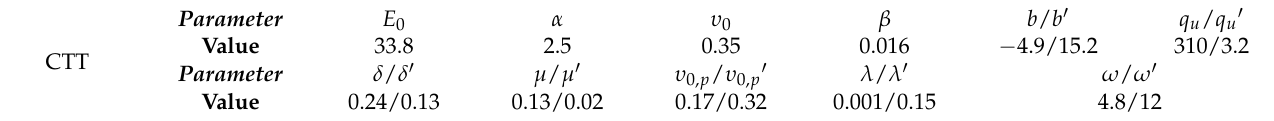
Figure 5. Comparison of prediction with experimental results of silica powder in the cyclic triaxial test ( a ) and ( b ): the stress–strain relations, ( c ) and ( d ): the radial–axial strain relations . Table 1. Parameters for empirical formulations in CTT.